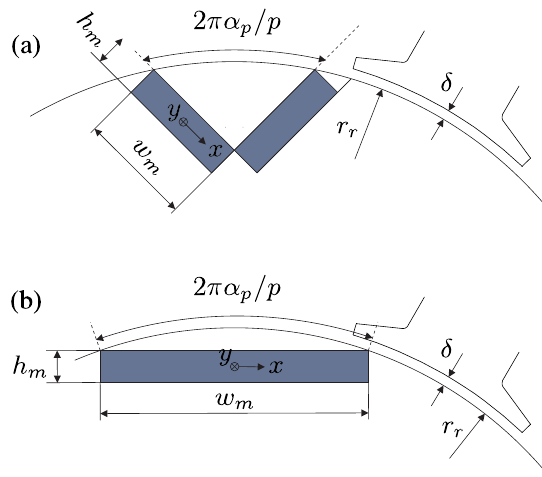
Figure A.1. Magnet dimensions and definition of rotor-cap coefficient α p (note that for the coordinate system fixed to PMs, the y -axis is directed into the paper): ( a ) V-shaped interior PMs; ( b ) Straight interior PMs.